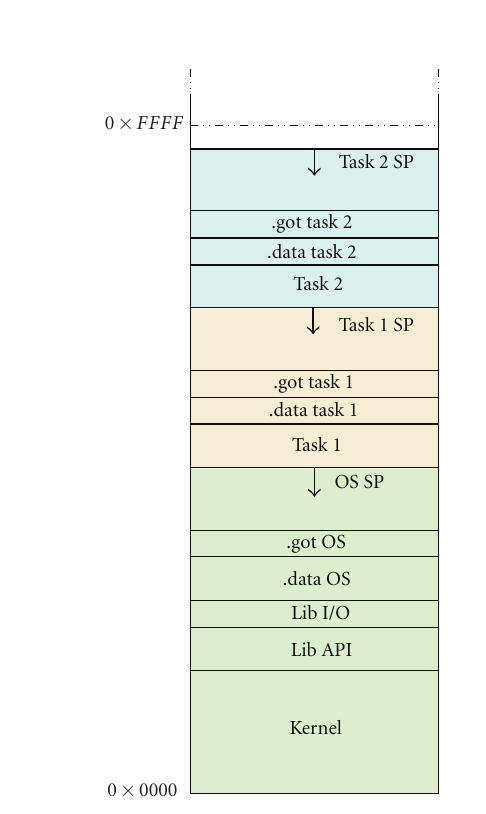
Figure 9: Memory